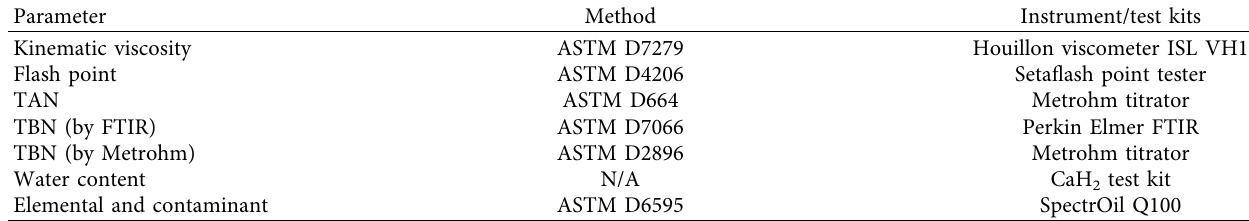
Table 1: Test methods used in the analytical